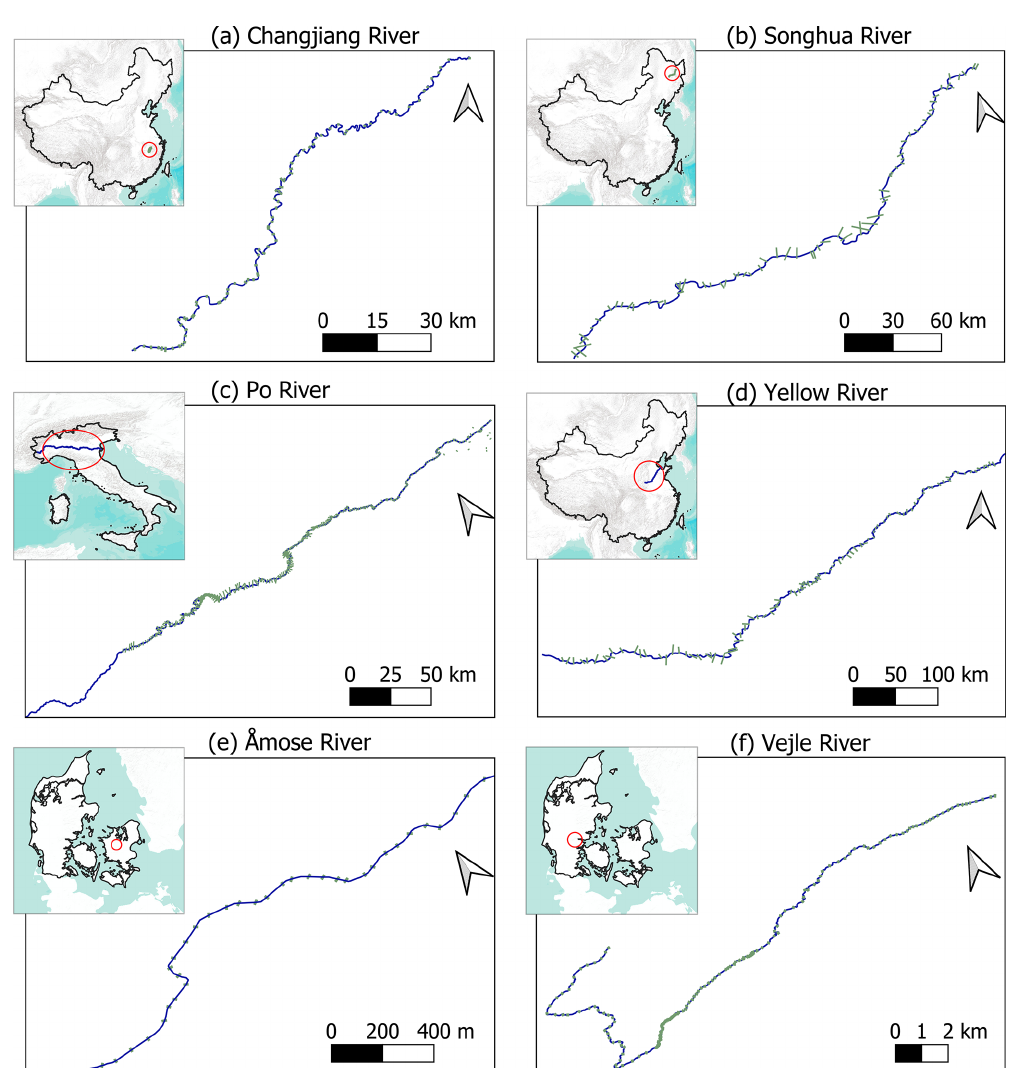
Figure A1. Location and river setting of six rivers. Short grey lines indicate cross-sections used to explore the hydraulic relationships.